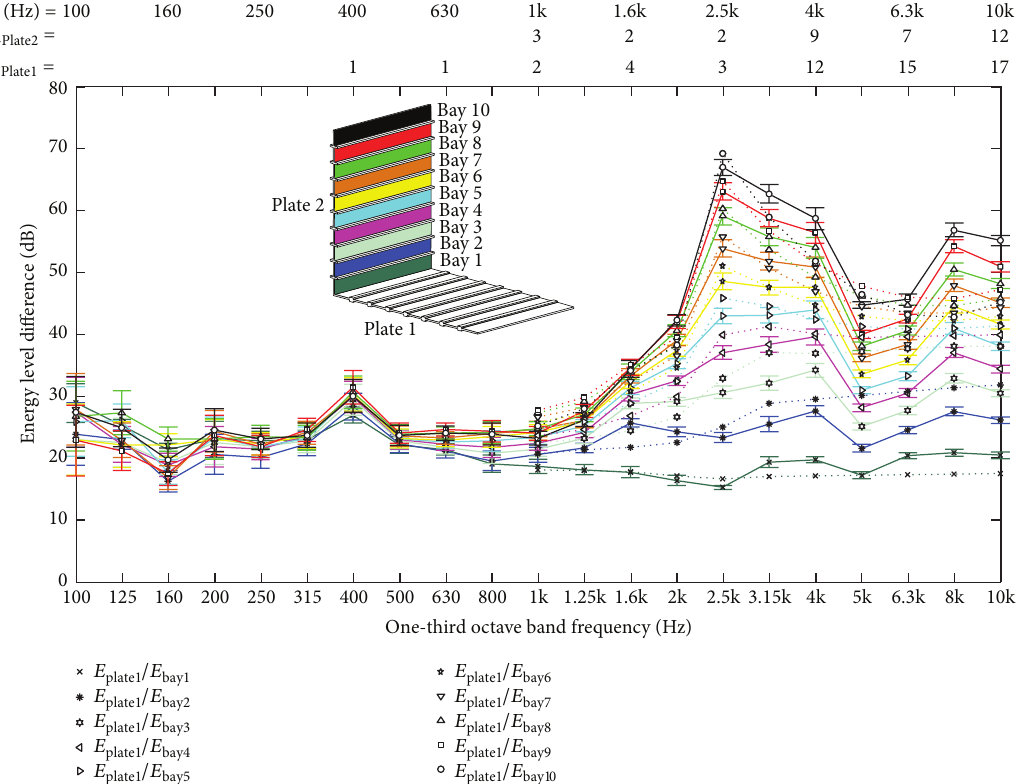
Figure 7: L-junction B. Excitation: Plate 1. Energy level differences between the periodic ribbed plate (Plate 1) and each of the bays that form the other periodic ribbed plate (Plate 2). Comparison between FEM and ASEA (FEM data are shown using markers with continuous lines; ASEA data are shown using markers with dotted lines). Upper 𝑥 -axis indicates the mode counts for each bay of the ribbed plates ( 𝑁 and 𝑁 Bay-Plate2